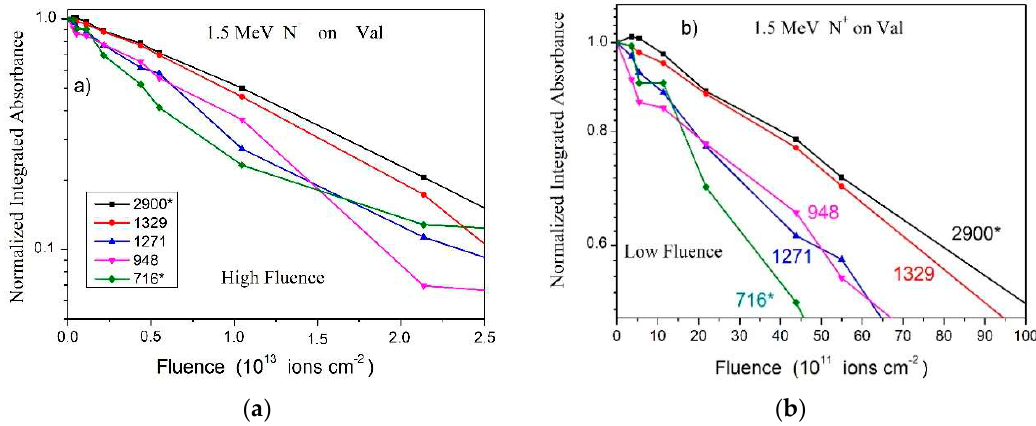
Figure 5. ( a ) Dependence on fluence of the integrated absorbance for several bands observed in the N + beam irradiation. ( b ) Zoom into the low fluence region. Data are normalized to 1 at F = 0. Colored lines are guides for eyes.